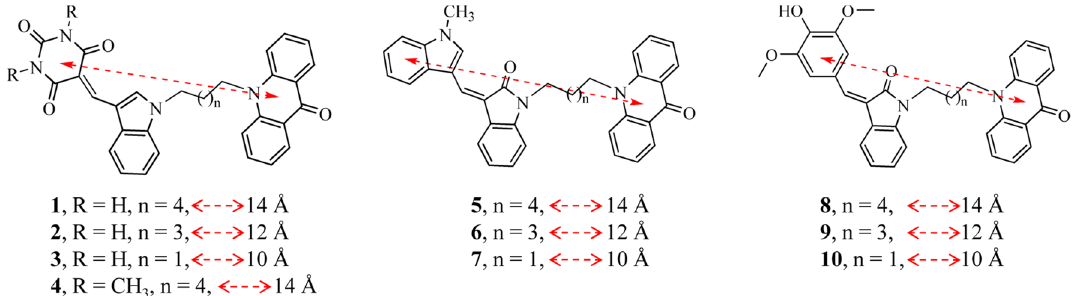
Figure 9. Rationally designed molecules for targeting the proposed electron transfer route and the AA binding site in